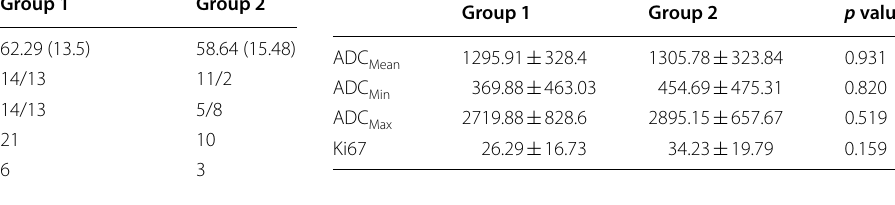
Table 1 The general characteristics of the patients and the side, Table 2 The mean and SD of ADC